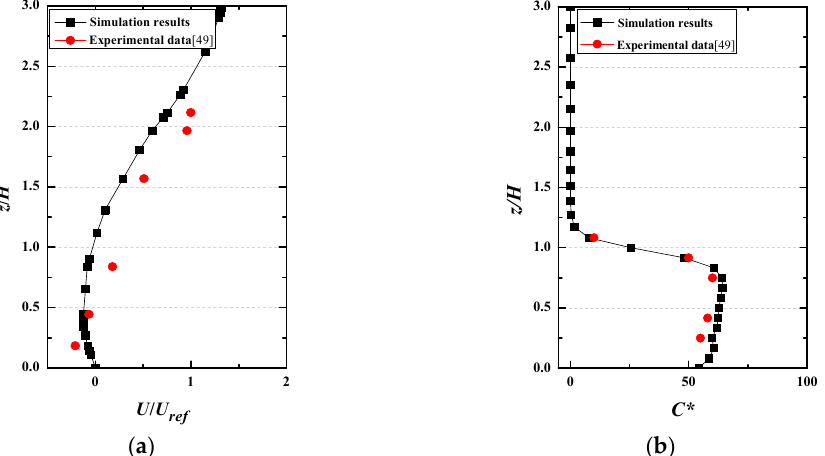
Figure 5. Vertical distributions of streamwise velocity ( a ) and normalized mean concentration ( b ) at x/H =